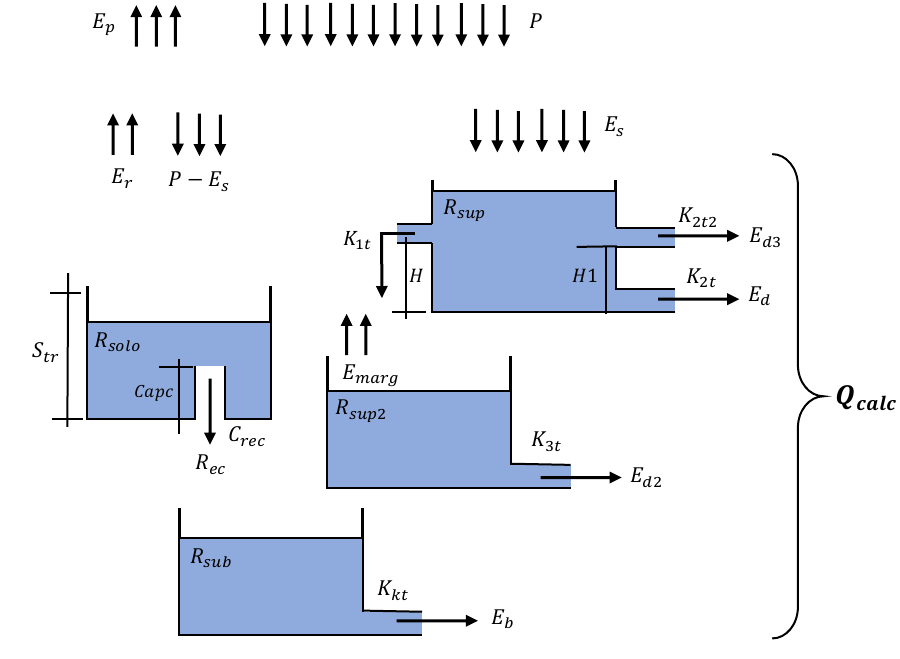
Figure 4. Conceptual diagram of the SMAP/ONS